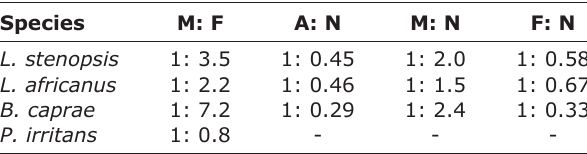
Table-2: Age- and sex-related distribution of lice and flea species infesting domestic goats in